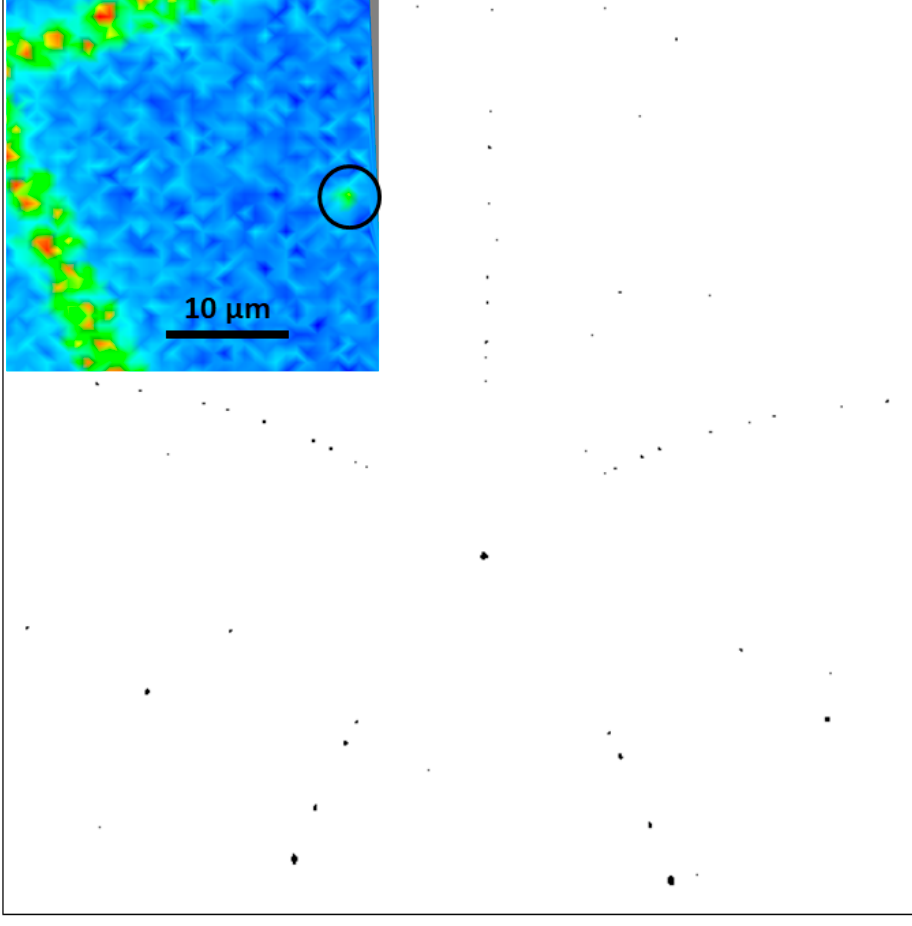
Figure 2. Background-subtracted Laue microdiffraction pattern of an Au crystal. The inset shows an X-ray fluorescence map of the Au L III fluorescence yield. The selected Au crystal is marked by a circle.